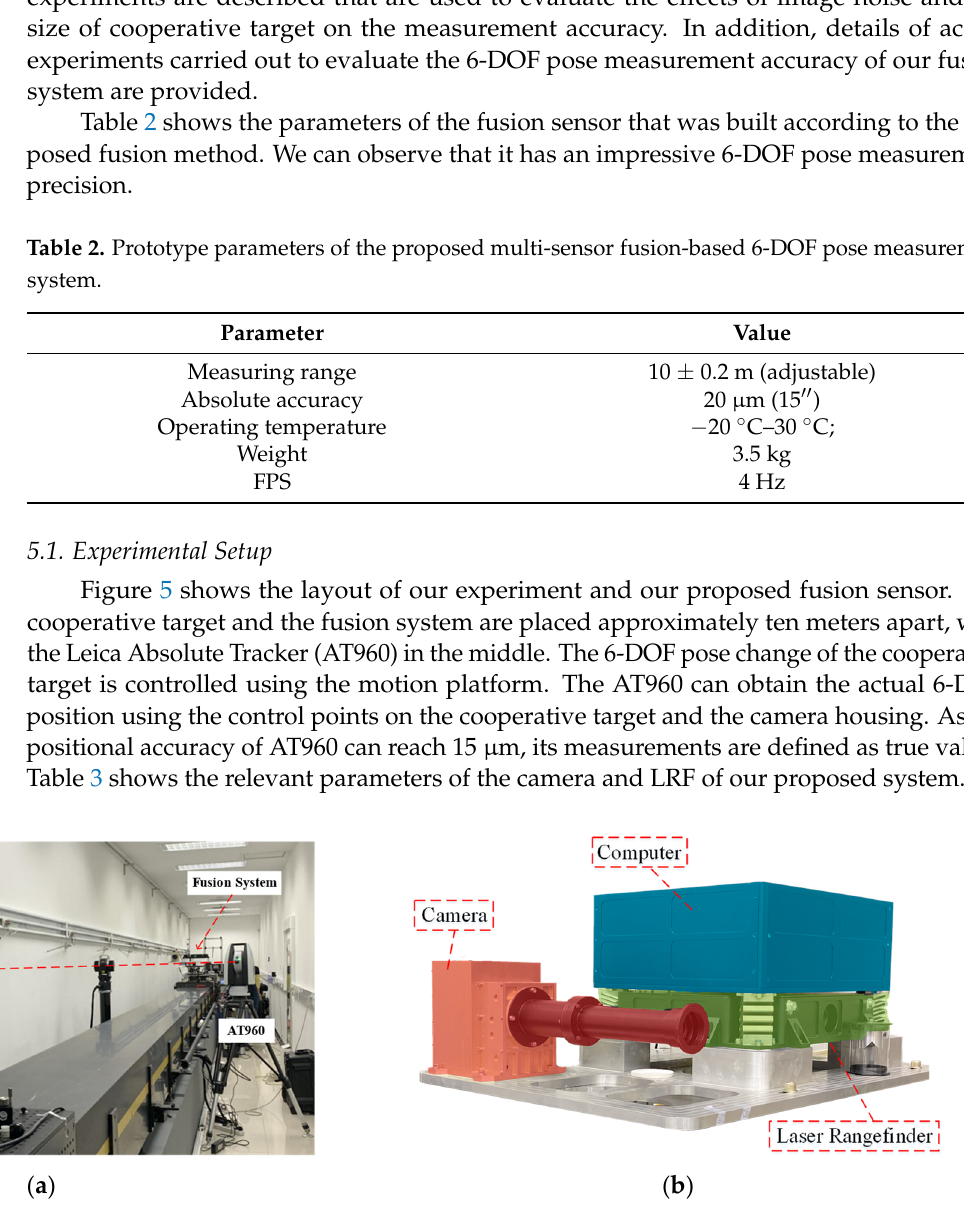
Figure 5. ( a ) Experimental layout; ( b ) prototype of proposed multi-sensor fusion-based 6-DOF pose measurement system.